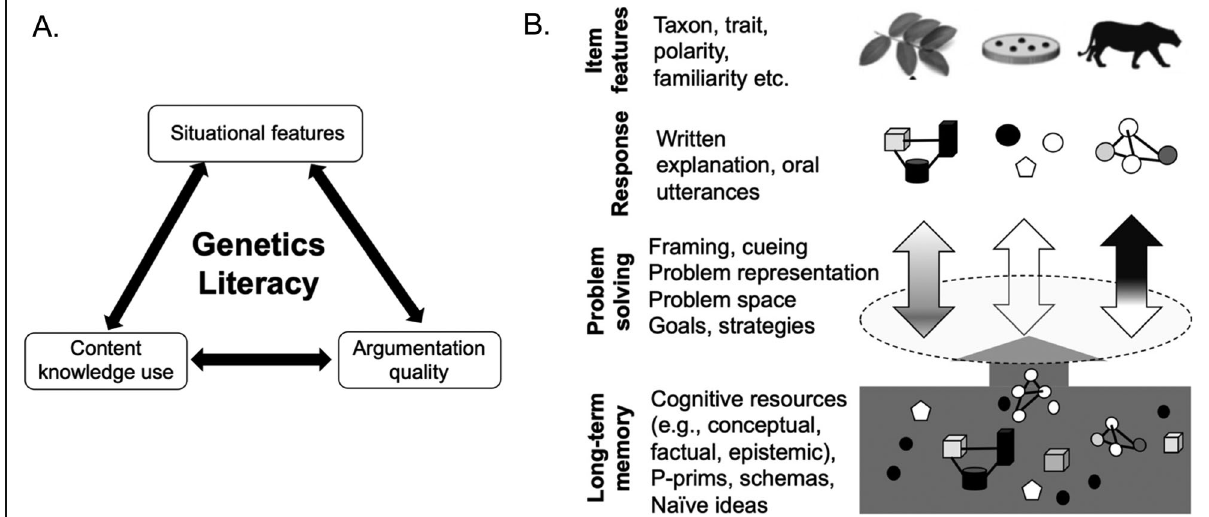
Fig. 1 Examples of conceptual frameworks developed for biology education research. a A three-part conceptual framework for genetics literacy encompassing situational features, content knowledge use, and argumentation quality (modified from Shea et al. 2015). b A conceptual framework for evolutionary reasoning encompassing long-term memory, problem-solving processes, and item features (similar to the situational features of Shea et al. 2015). Modified from Nehm